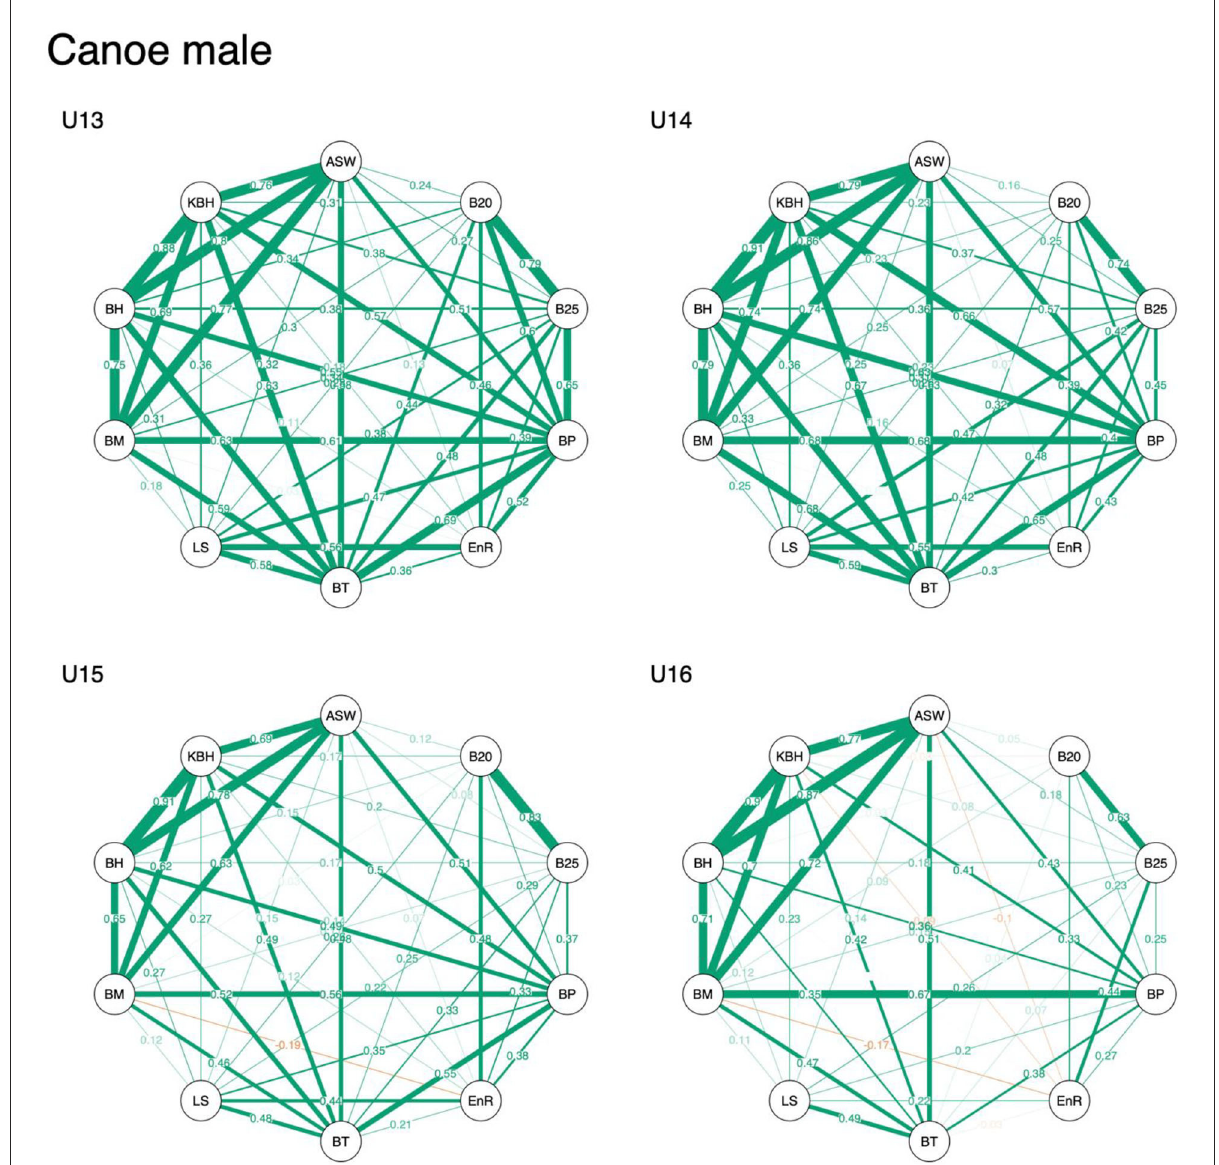
FIGURE3 Network representation of a correlation matrix of different test items of anthropometric, physical fitness, and sport-specific performance measures in young male canoeists. ASW, arm span width; B20, 2,000m on-water race; B25, 250m on-water race; BP, bench press and bench pull; EnR, 1,500m run; BT, underhand ball throw test; LS, 30m linear sprint; BM, body mass; BH, body height; KBH, kneeling body